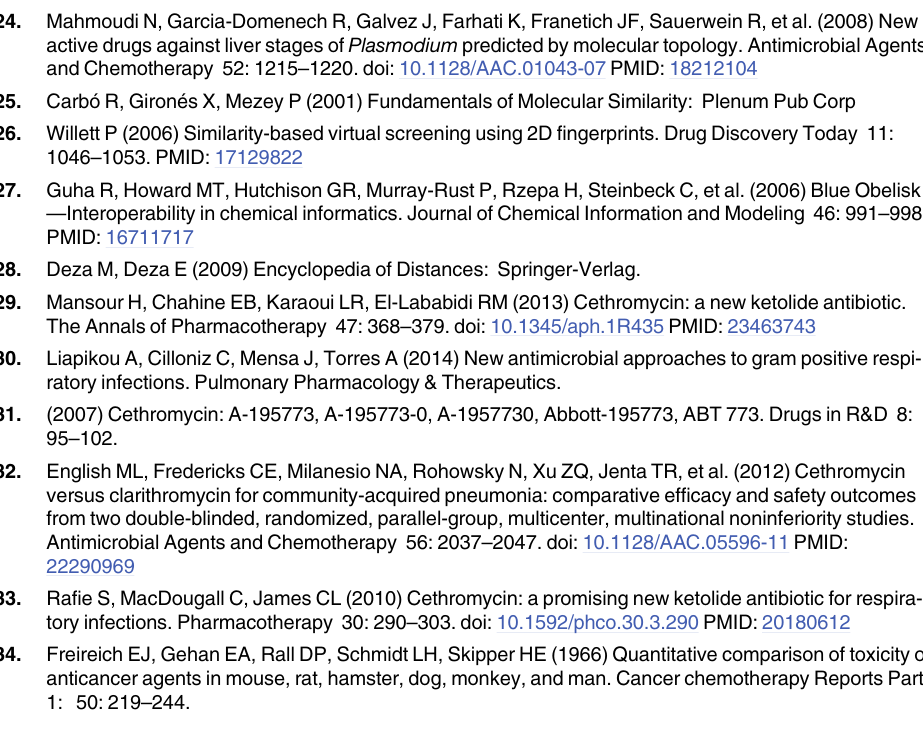
PLOS ONE | DOI:10.1371/journal.pone.0125593 May 7,